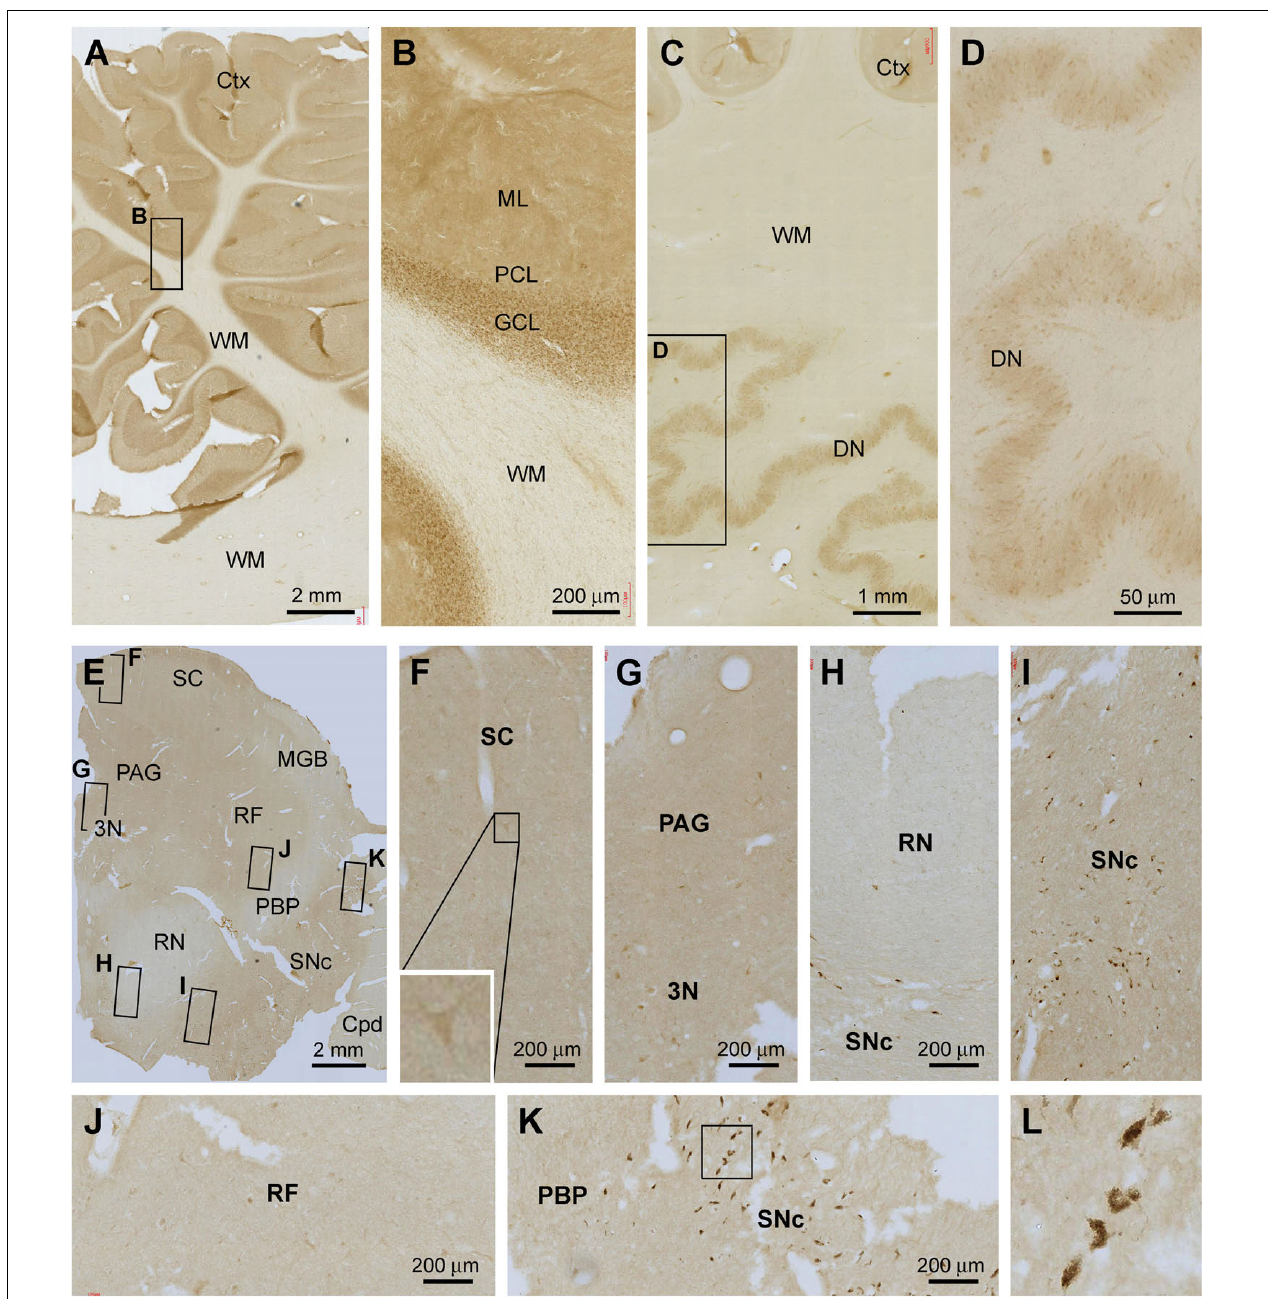
FIGURE 7 | Representative images illustrating Shank3 IR in the cerebellum and midbrain. Panels (A,B) show the labeling in the cerebellar cortex, with diffuse neuropil labeling occurred across the molecular layer (ML), cellular labeling in the granule cell layer (GCL), whereas no labeling in the Purkinje cell layer (PCL) and the white matter (WM) (B) . Panels (C,D) show the IR in the dentate nucleus, with the light neuropil and cellular labeling seen in the mantle of this nucleus (D) . Panels (E–L) show Shank3 IR in a section at the level of the superior colliculus (SC). Light labeling is present across the section, while individual neuronal perikarya are visible at high magnification in various areas as indicated. The cells in the pas compacta substantia nigra (SNc) are pigmented (unlikely representing specific immunolabeling) (I,K,L) . PAG, periaqueduct gray; MGB, medial geniculate body; 3N, third cranial nerve nucleus; RF, reticular formation; RN, red nucleus; PBP, parabrachial pigmented nucleus; Cpd, cerebral peduncle. Scale bars are as indicated in each panel.